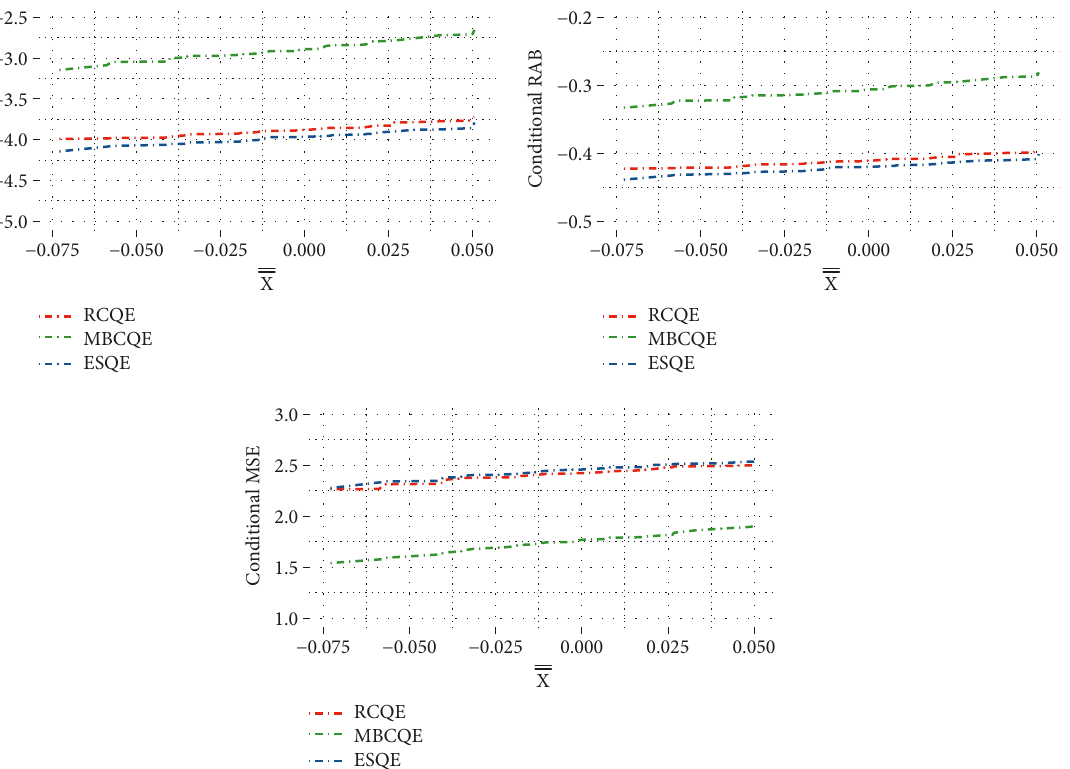
Figure 3: CB, CRAB, and CMSE for estimators: linear mean function, α � 0 .